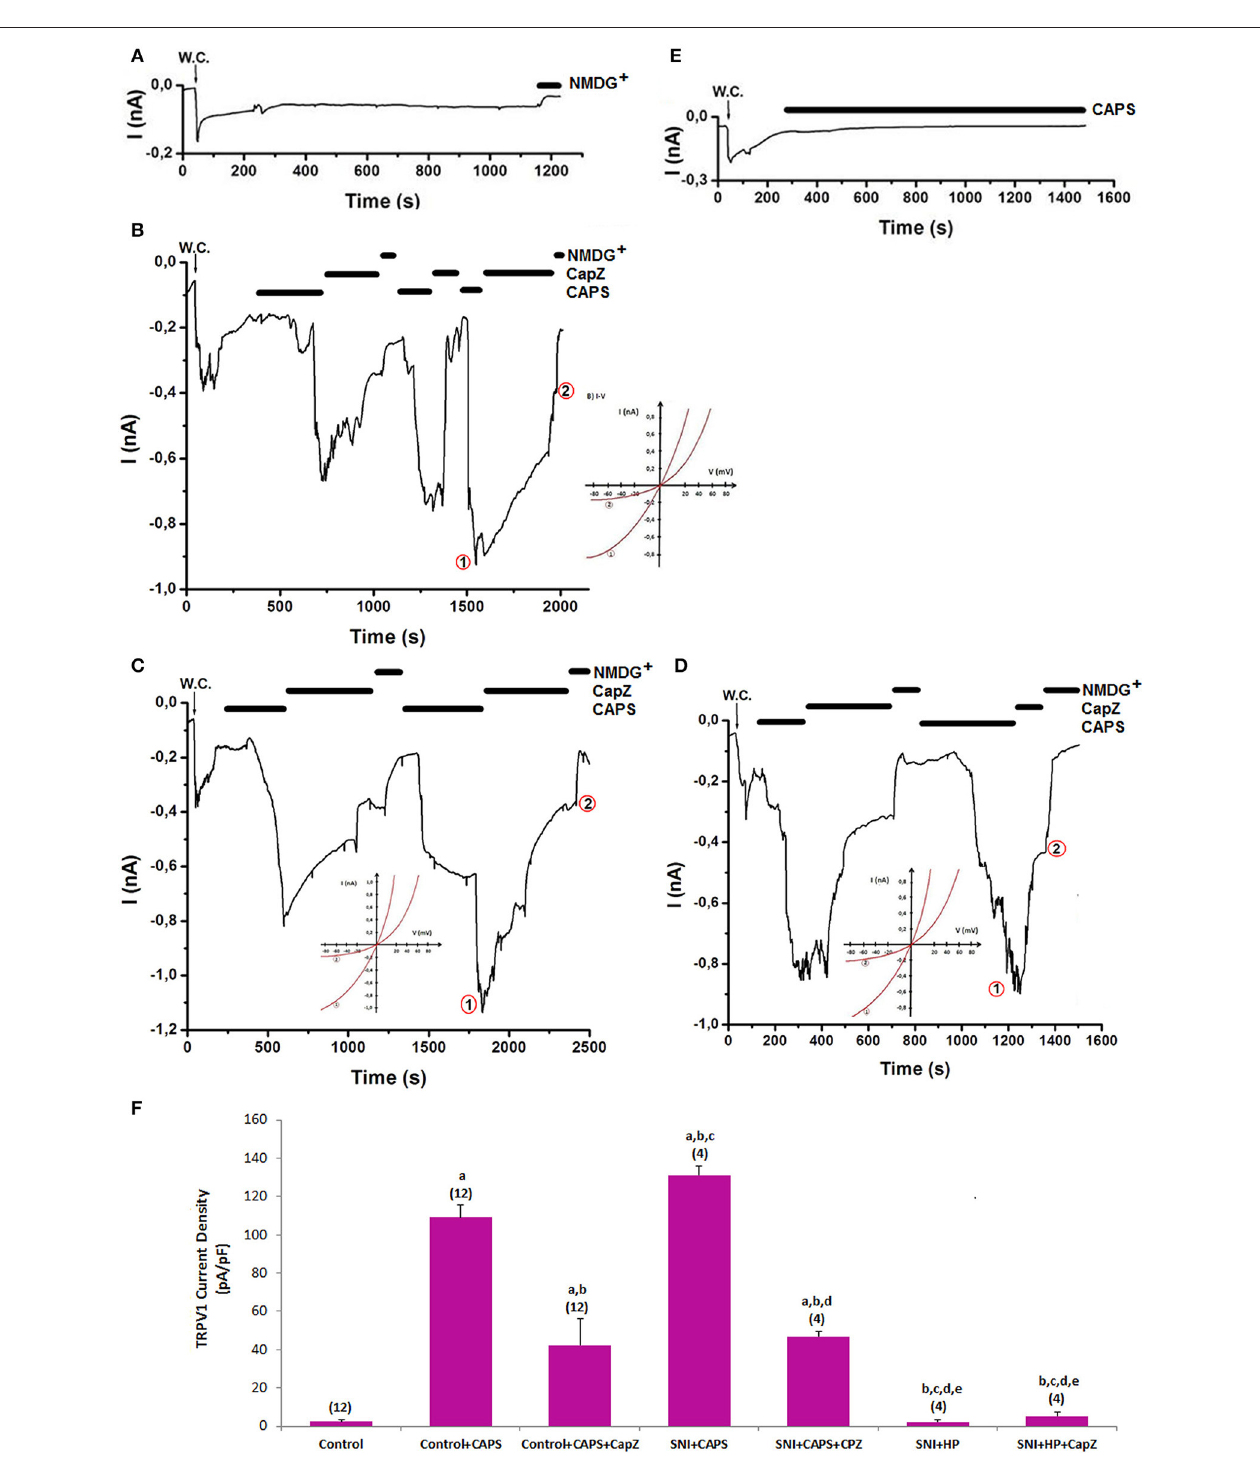
FIGURE 5 | Effects of HP on TRPV1 channel activation in dorsal root ganglion neuron (DRGN) of control and SNI-induced rat. The TRPV1 currents in DRGN were stimulated by extracelular capsaicin (CAPS and 0.01 mM in patch chamber) but they were inhibited by extracellular CaPZ (0.1 mM) in the patch-chamber. W.C.: Whole cell. Control (without SCI induction and stimulation): Original recordings from control neuron (A) . (B) . Control + CAPS group (without SCI induction). (C) . SNI group (with SCI induction). (D) . SCI + HP group: The rats received HP after SCI induction. (E) . HP group: The rats received HP without SCI induction. (F) . TRPV1 channel current densities in the DRGN. The numbers in parentheses indicated n numbers of groups were indicated by numbers in parentheses. ( a p ≤ 0.001 vs. control. b p ≤ 0.001 vs. control + CAPS group. c p ≤ 0.001 vs. control + CAPS + CapZ group. d p ≤ 0.001 vs. SNI + ADPR group. e p ≤ 0.001 vs. SNI + ADPR + ACA